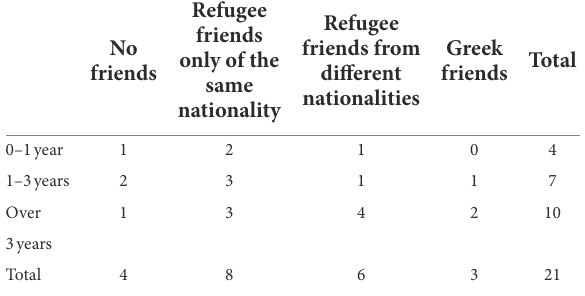
TABLE 3 Refugee children’s friendship differences among boys and